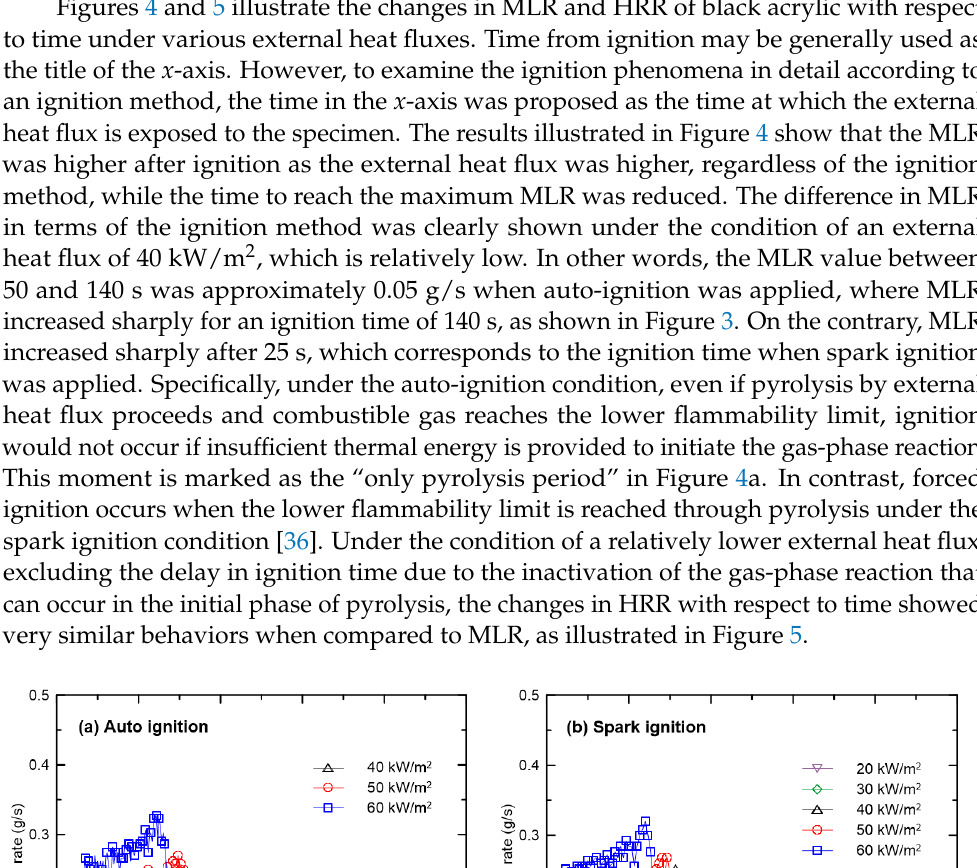
Figure 5. Time histories of heat release rate under the conditions of various external heat fluxes for the auto and spark ignitions. To examine the global burning behaviors of acrylic with respect to the external heat flux, Figure 6a,b show integral values over time, as well as maximum and mean values that are related to MLR and HRR. TML and THR in the figure represent the total mass loss (kg) due to pyrolysis and total heat release (kJ) due to the gas-phase reaction, respec- tively. TML and THR showed constant values regardless of the external heat flux because the same specimen was applied. The maximum and mean values of MLR and HRR tended to linearly increase with the external heat flux, which was also observed in previous stud- ies [12,13]. Furthermore, it was clearly shown that auto and spark ignitions, which showed different ignition phenomena under relatively low heat flux conditions, had no significant impact on global burning behaviors.